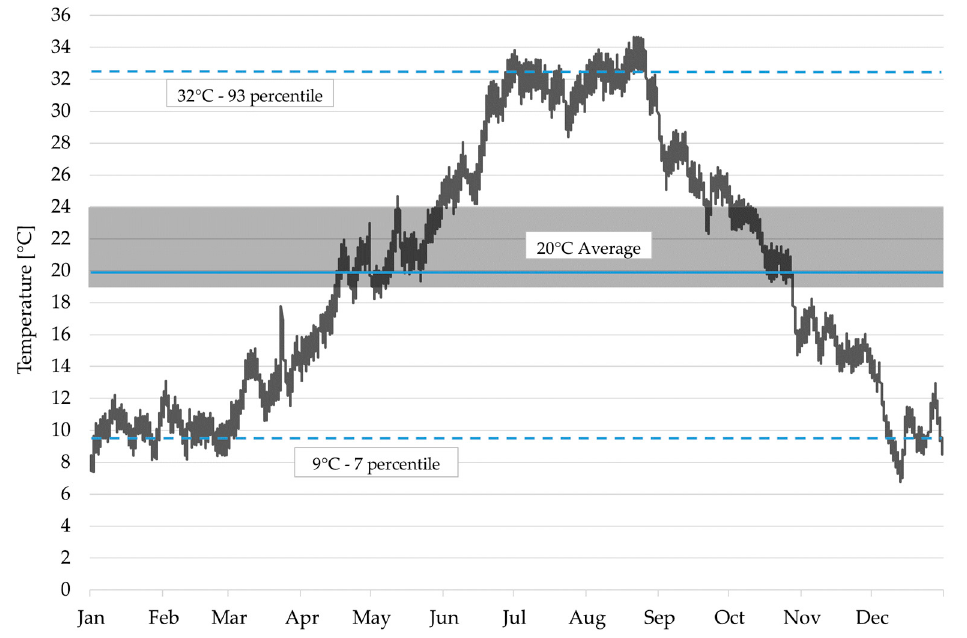
Figure 22. Trend of historic climate hourly values of T and statistical limits of 93rd and seventh percentiles in room X vs. the range recommended by the Italian D.M. 10.05.2001 [16] (gray band).